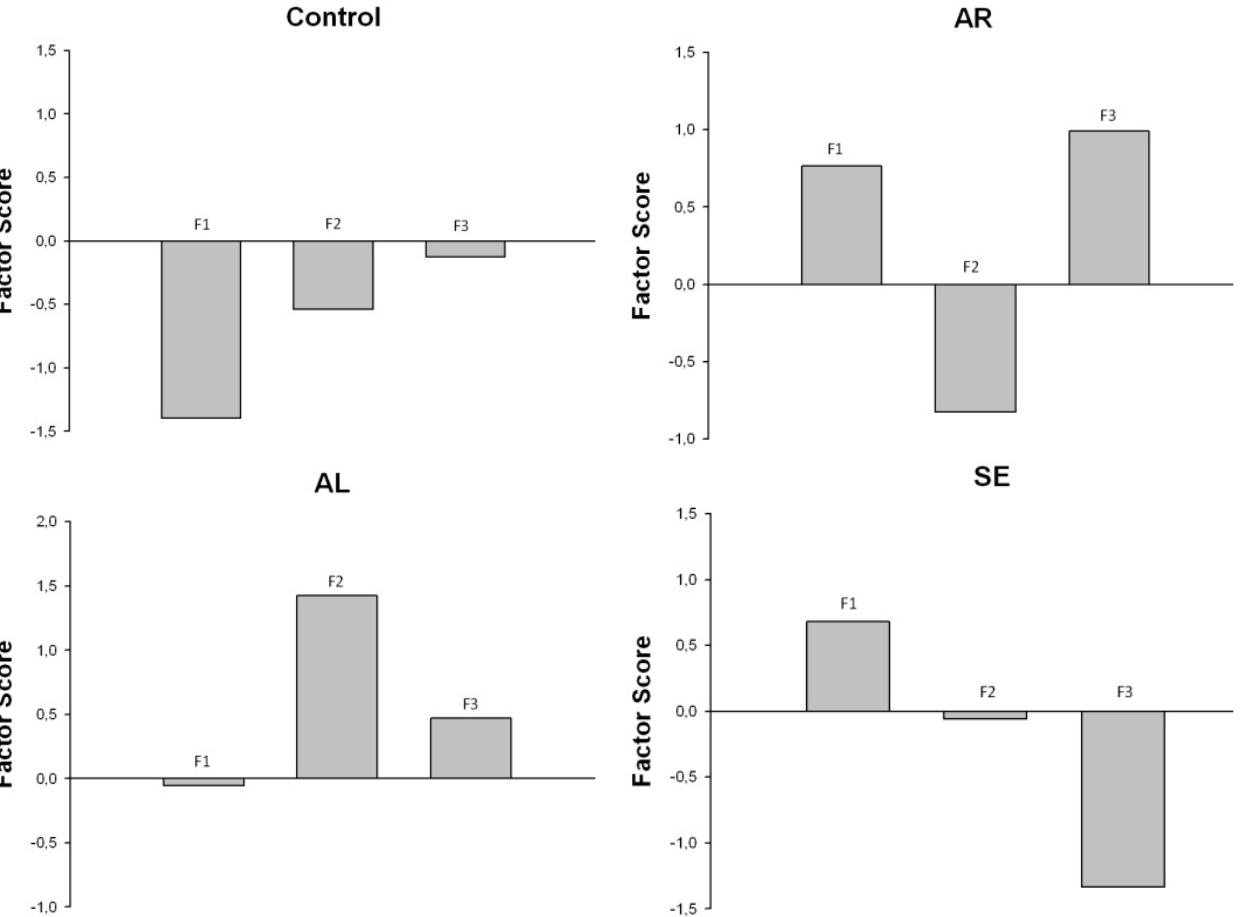
Figure 4. Estimated factor scores from the sampling stations (Control, AR, AL, SE). The factor scores quantify the prevalence of each factor for every station and are established to define each factor.